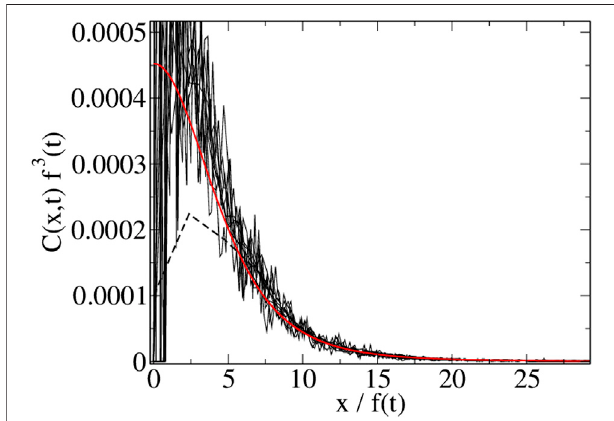
FIGURE 3 | The predicted/theoretical concentration fi eld at different γ -values when D (cid:1) 1 and t (cid:1) 10. The black curves show Pattles [39] solution 0